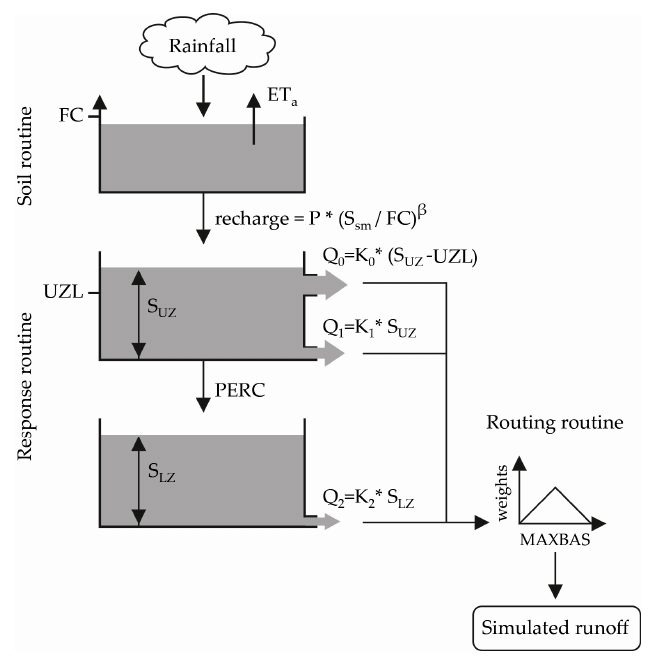
Figure 2. Model structure of HBV-light as used in this study. Modified from Seibert [63].